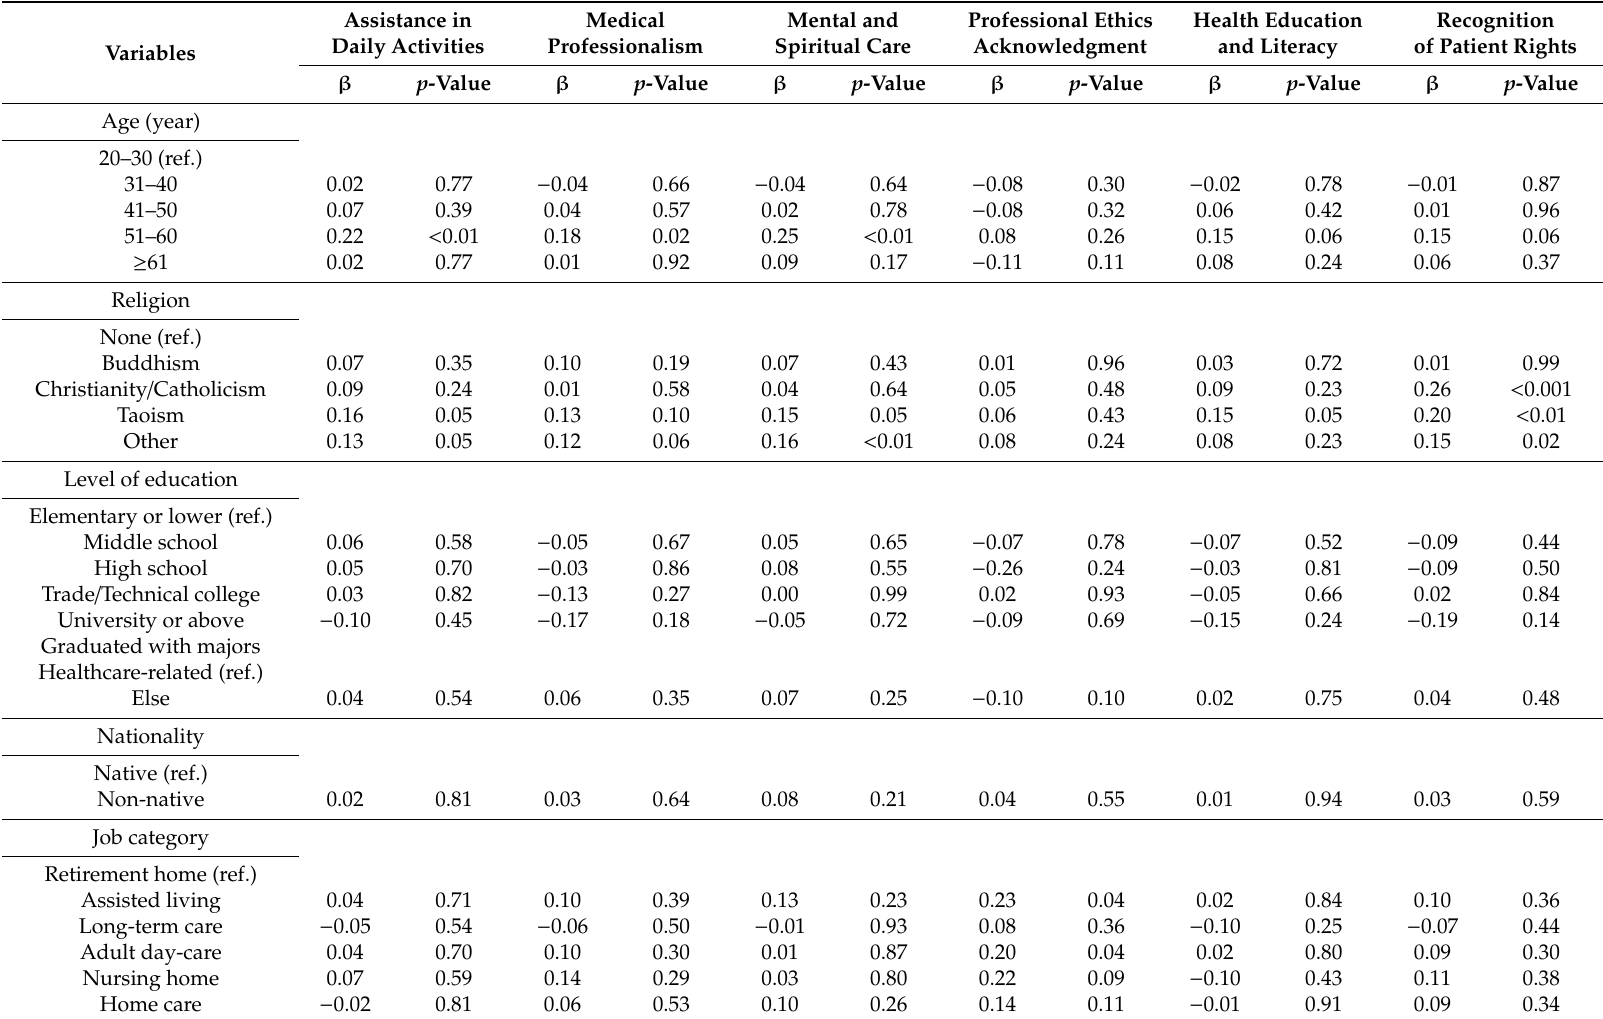
Table 3. Factors a ff ecting competency level in di ff erent domains in disability nursing